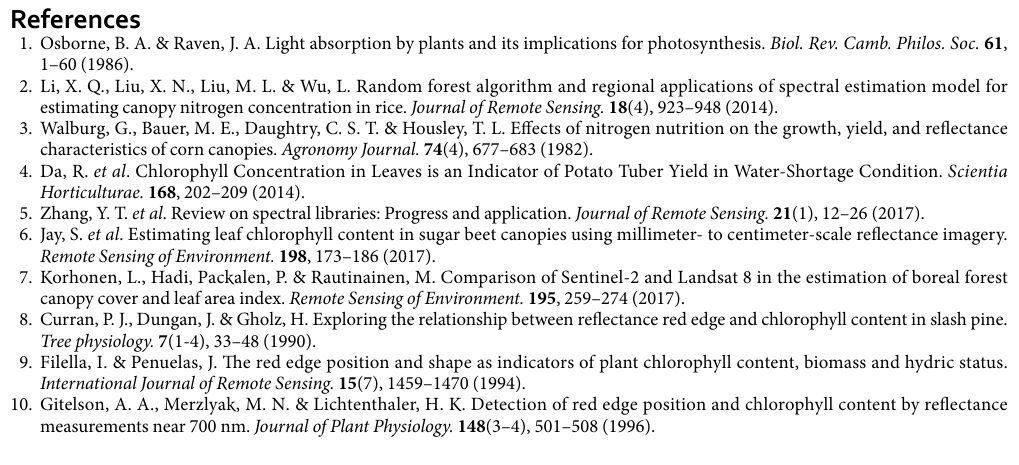
9 Scientific REPORTS | (2018) 8:3756 | DOI:10.1038/s41598-018-21963-0